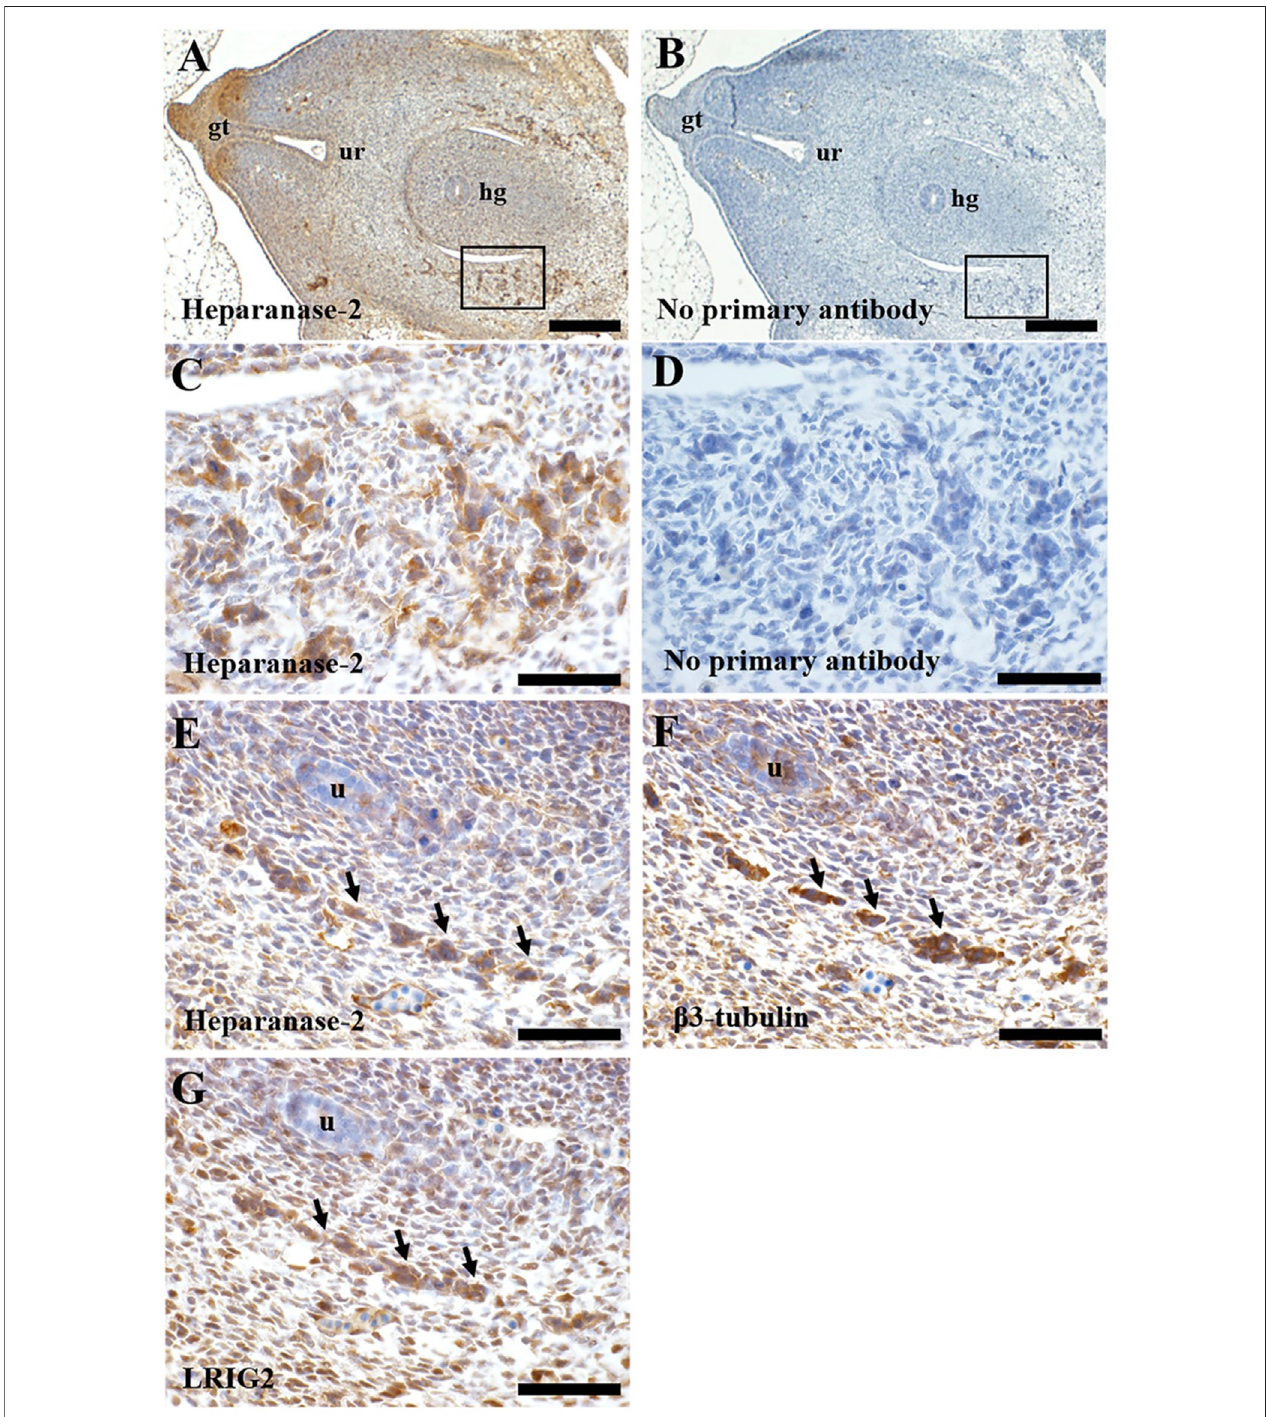
FIGURE 6 | Immunohistochemistry of human embryos. Transverse sections through a seven-week human embryo at the level of the hindgut. All sections were counterstained with haematoxylin (blue nuclei). In all sections, ventral (the front of the embryo) is to the left, and dorsal is to the right. A and B are low power views, while the other frames are high power views. (A) . Immunostaining for heparanase-2 (brown signal). Note positive staining in collections ofcells (one area isboxed) fl anking the hindgut (hg). Positive immunostaining is also evident in the genital tubercle (gt) and the forming urethra (ur). (B) . Adjacent section with primary antibody omitted; no brown signal is detected. (C) . High power approximating to the boxed area in (A) . Note collections of cells that immunostain for heparanase-2. (D) . Adjacent section to that depicted in (C) but with primary antibody omitted. (E – G) . These are serial sections fl anking the hindgut taken from the same embryo but more cranial to the area viewed in (C) . Note the cord of cells (arrowed) that are positive for each of these three proteins: heparanase-2 (E) ; β 3-tubulin (F) , a protein enriched in neurons; and LRIG2 (G) . The embryonic ureter (u) is seen in the same three sections. Scale bar is 200 µm in A and B, and 20 µm in (C – G) .